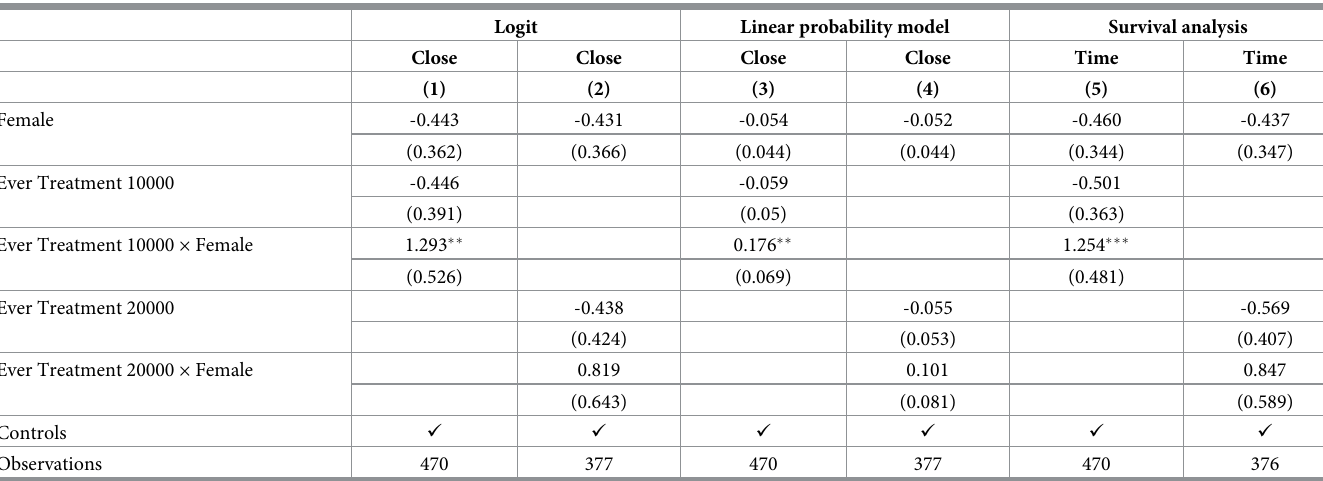
Table 9. Gender differences in initial business